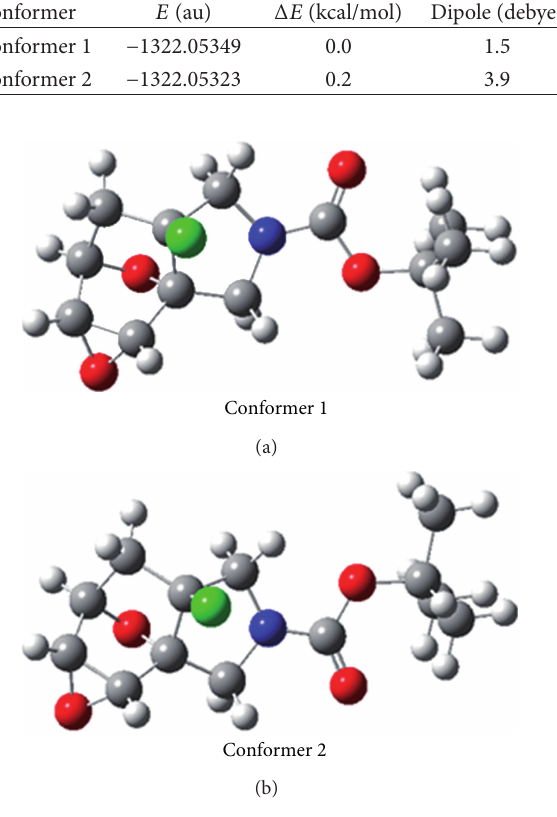
F 1: Two stable conformers of the title compound calculated atB3LYP/6-31G(d,p)level.etorsionangles,C22–N13–C15=O11, for Conformer 1 and 2